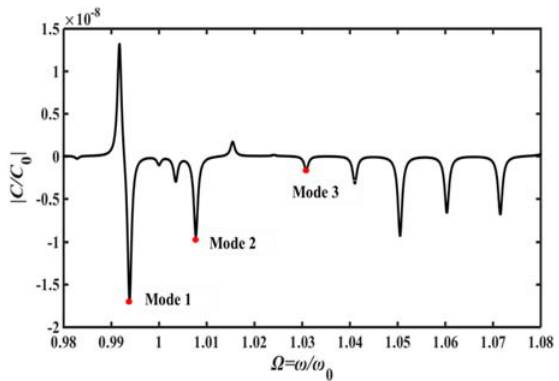
Figure 4. Normalized capacitance versus driving frequency.